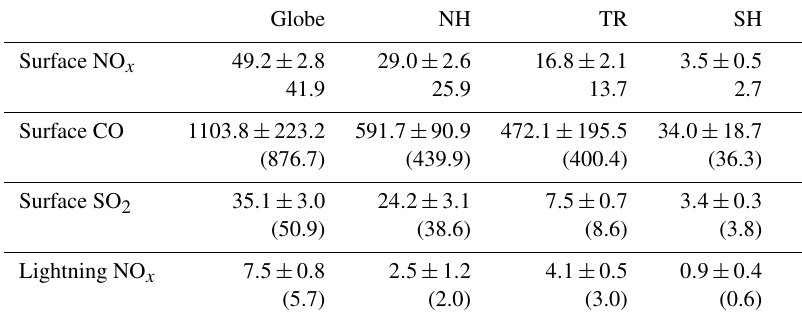
Table 7. The global and regional mean surface NO x (in TgNyr − 1 ), CO (in TgCOyr − 1 ), and SO 2 emissions (in TgSyr − 1 ) and lightning NO x sources (in TgNyr − 1 ) obtained from the a priori emissions (in brackets) and a posteriori emissions for the period 2005–2018. The results are shown for the Northern Hemisphere (NH, 20–90 ◦ N), the tropics (TR, 20 ◦ S–20 ◦ N), the Southern Hemisphere (SH, 90–20 ◦ S), and the globe (GL, 90 ◦ S–90 ◦